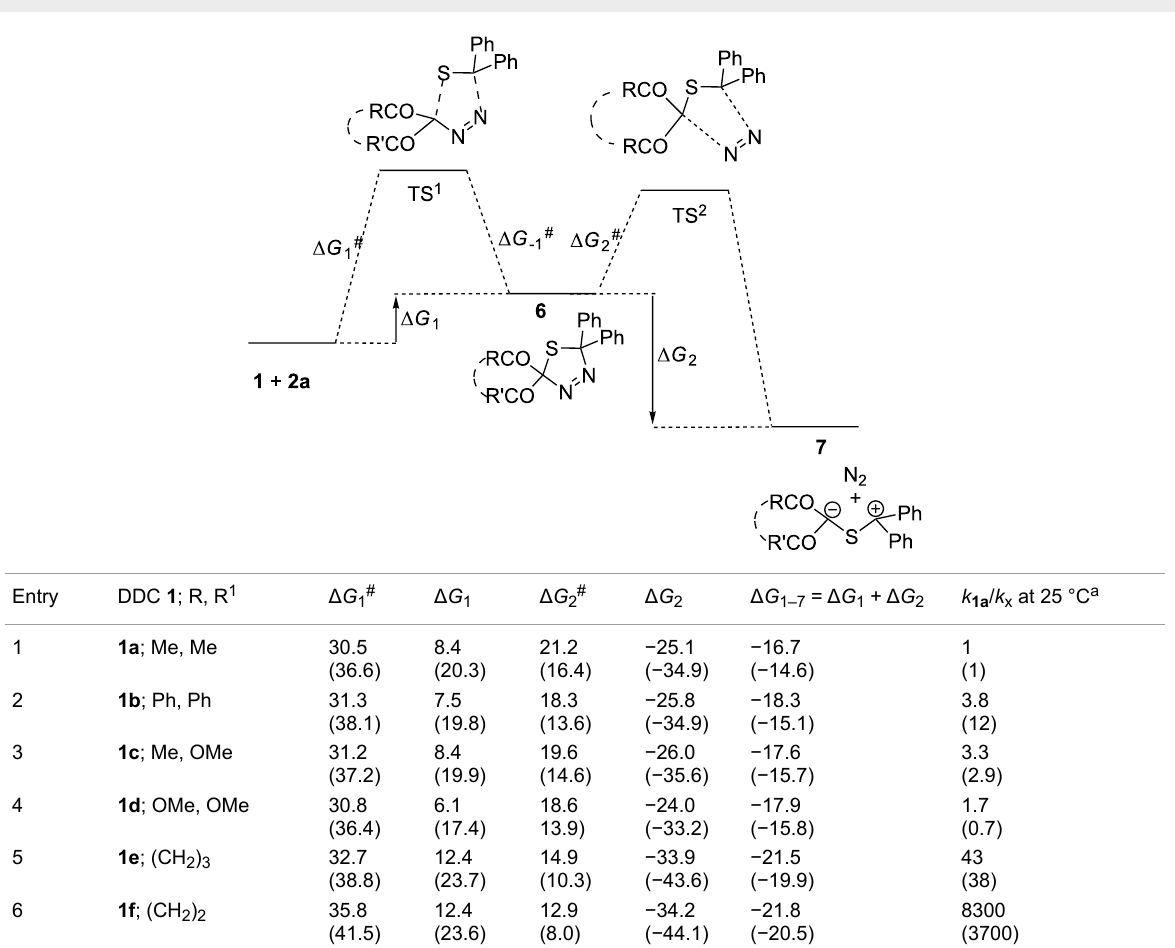
Table 1: Calculated relative energies (in kcal·mol − 1 ) and relative reaction rates for cycloaddition reactions of diazo compounds 1a – g with thiobenzo- phenone 2a using the PBE1PBE/6-31G*//PCM (benzene) method. The energies calculated via B3LYP/6-31G*//PCM (benzene) are given in paren-